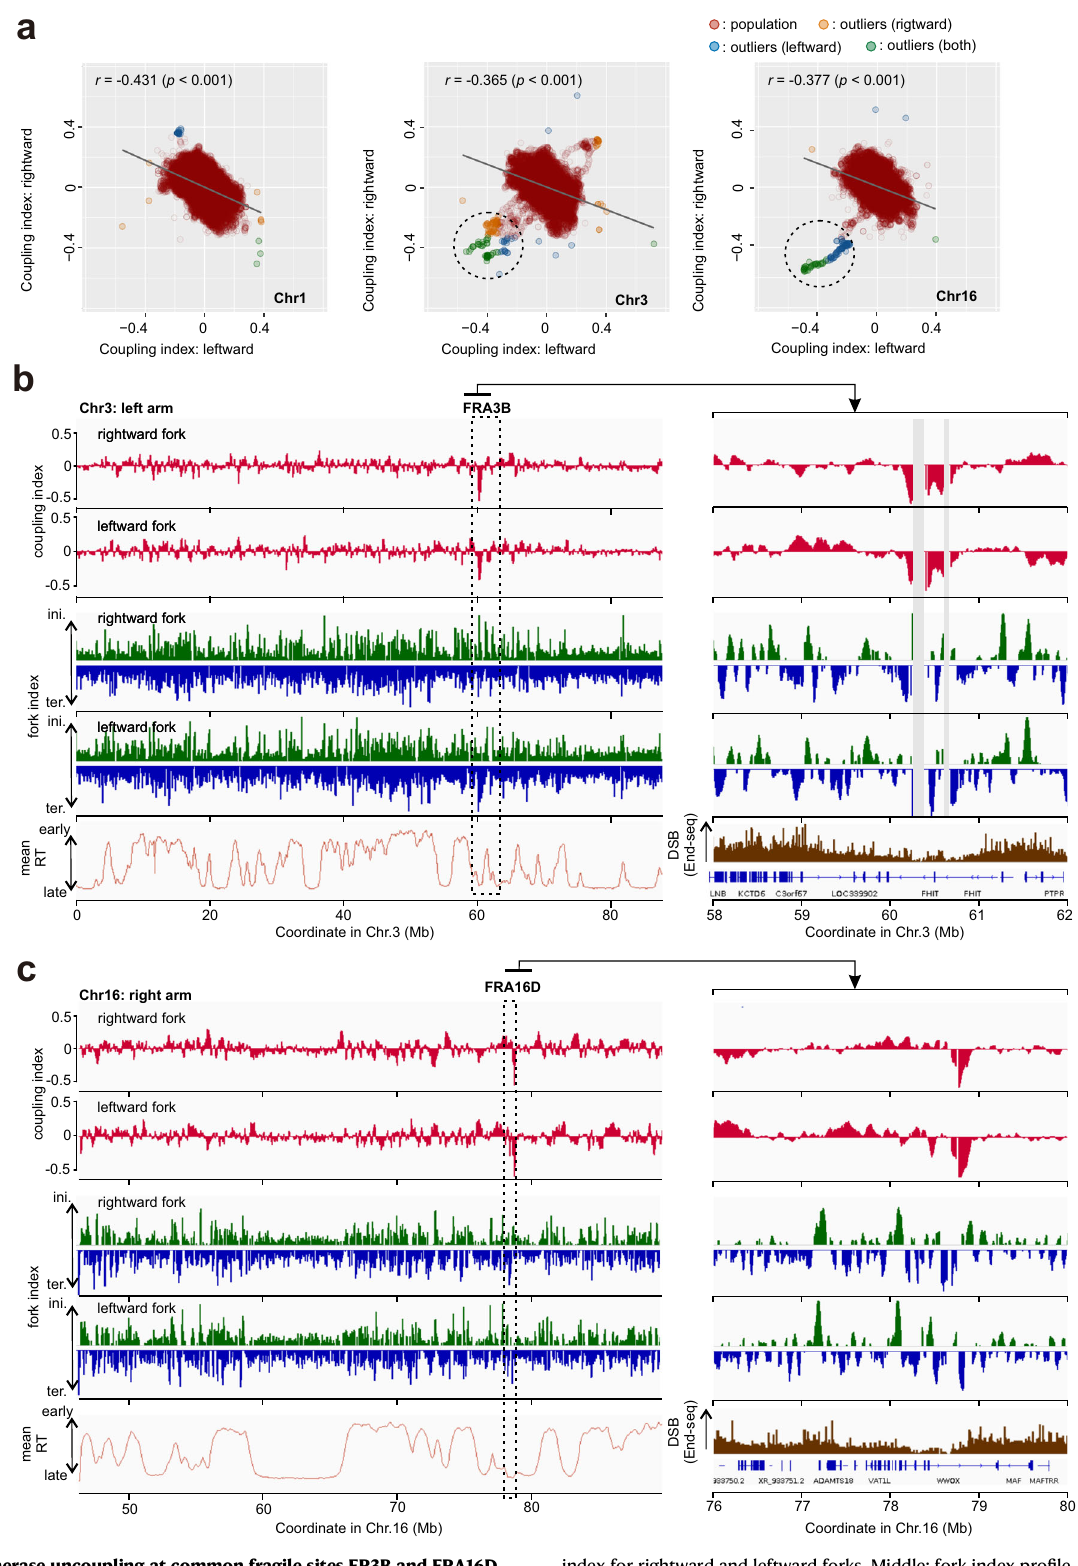
index for rightward and leftward forks. Middle: fork index pro fi le. Bottom: mean replicationtiming (meanRT)orDSBdatafor the FRA3Bregion on chromosome 3. Grey bars mask regions where the pro fi les are void due to a low count of sequencing reads (see methods). c The equivalent data for the FRA16D region of chromosome 16. Replication timing data for HCT116 cells are derived from Zao et al. 24 . Data of DSBs from End-seq are derived from Tubbs et al. 35